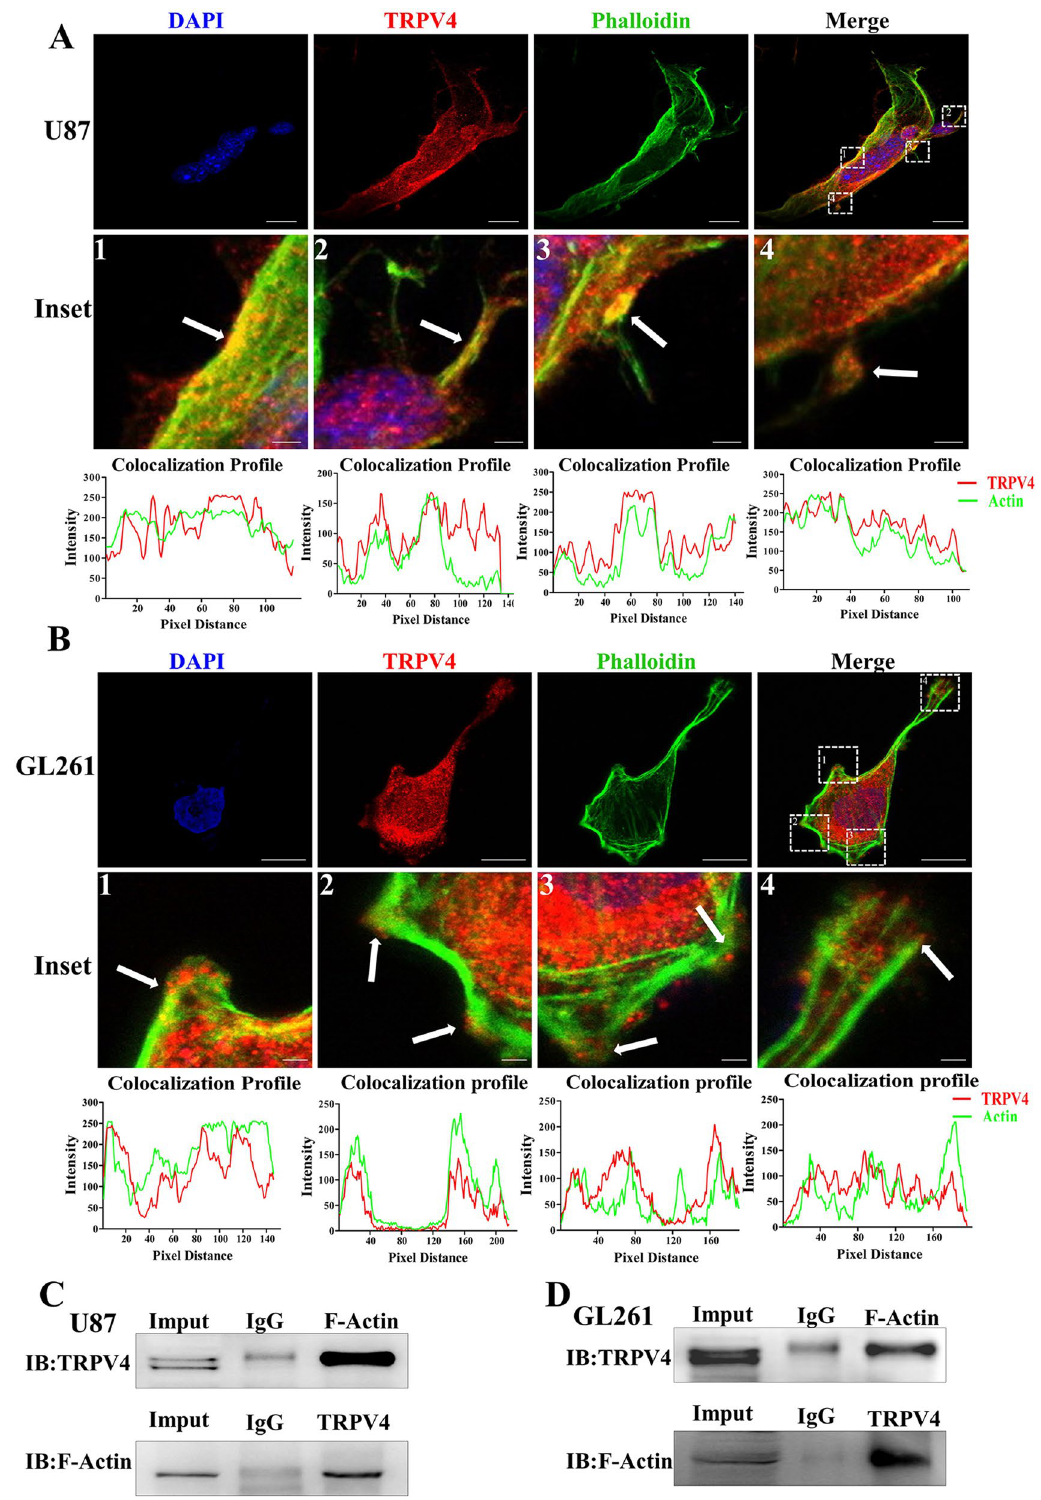
Figure 3. TRPV4 colocalizes and interacts with cytoskeletal protein F-actin. ( A ) U87 cells were plated on dishes for IF, and F-actin was labeled with FITC-phalloidin (green). TRPV4 was labeled with anti-TRPV4 antibody followed by TRITIC-conjugated antibody (red). Inset images show the TRPV4 distribution at the membrane and cellular protrusions. The colocalization profiles of inset images were analyzed by ImageJ and are listed below the image. Scale bar = 20 µm and 2 µm. ( B ) GL261 cells on confocal dishes for F-actin and TRPV4 staining to show colocalization. The inset images and colocalization profiles are listed below. Scale bar = 10 µm and 1 µm. ( C - D ) Coimmunoprecipitation of TRPV4 and F-actin: the whole-cell lysate was immunoprecipitated (IP) with anti-TRPV4 or F-actin antibody, and the immunocomplexes were immunoblotted (IB) with the opposite antibody in U87 and GL261